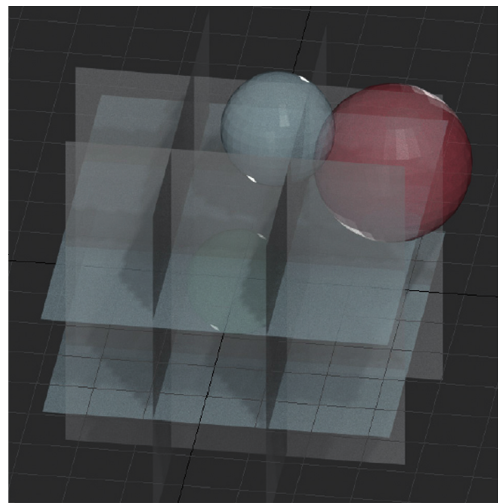
Figure 15: MBR model in Example 2(a).